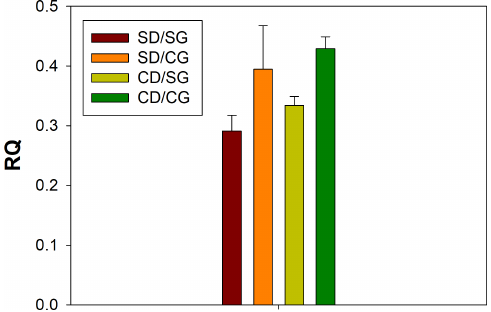
Figure 1. Respiratory quotient (RQ) values. The four treatments are indicated in different colours. Error bars indicate the standard error of the mean ( n = 3). SD/SG: no dry–rewetting disturbance/no herbicide; SD/CG: no dry–rewetting disturbance/herbicide; CD/SG: dry–rewetting disturbance/no herbicide; CD/CG: dry–rewetting dis- turbance/herbicide.